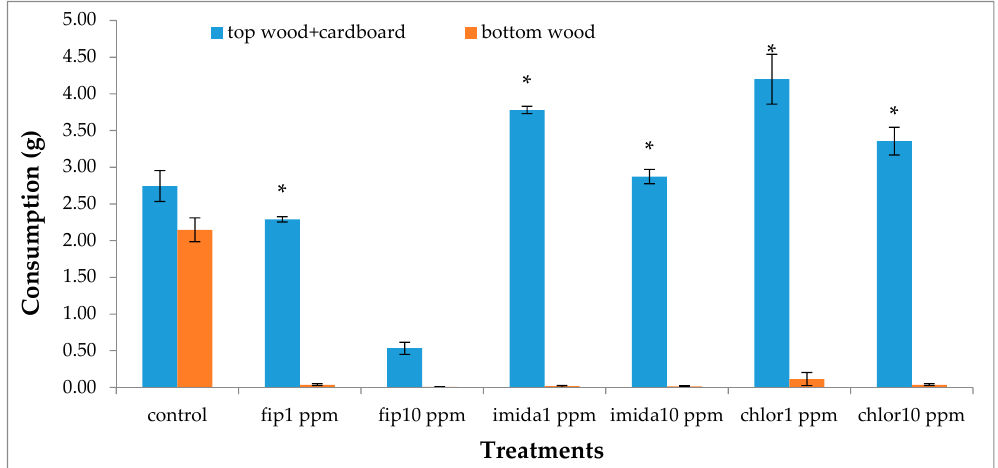
Figure 7. Comparison of mean food consumption (±SEM) between top foraging site and bottom foraging site within the same treatment after one month (12 days for fip10 ppm) of treatment. Top foraging site consumption included consumption of wood and cardboard and bottom foraging site consumption included consumption of wood only as there was no cardboard there. Asterisk (*) on top of graph bars shows significant difference between top and bottom foraging sites within the same treatment.